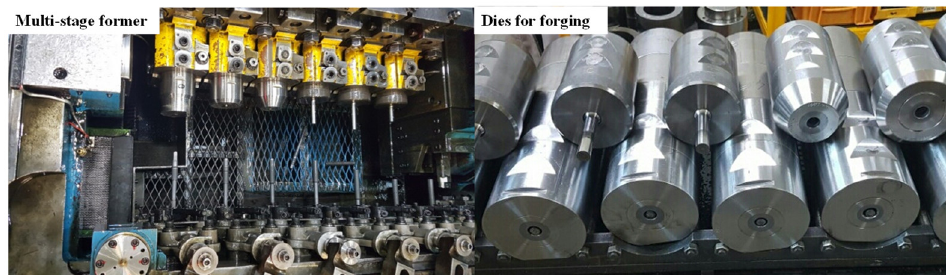
Figure 2. Experimental set-up for multi-stage cold forging and the dies used.